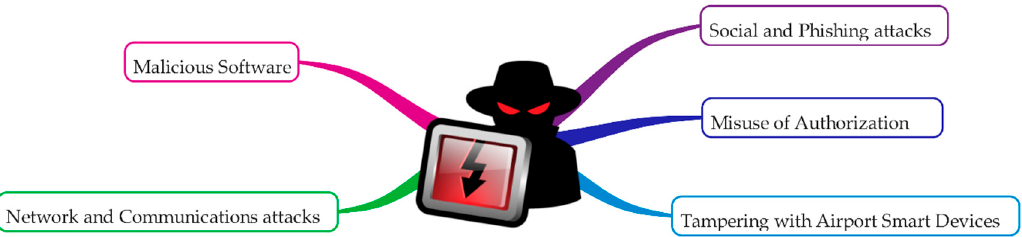
Figure 6. Cybersecurity malicious threats categories.